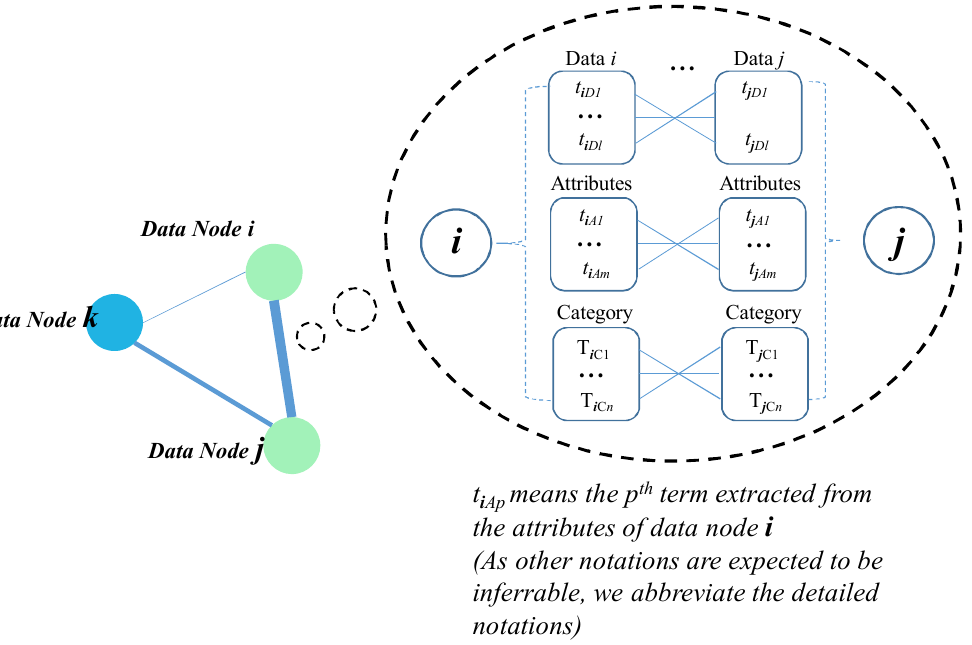
Figure 4. An Example of the OGD Graph and Detailed